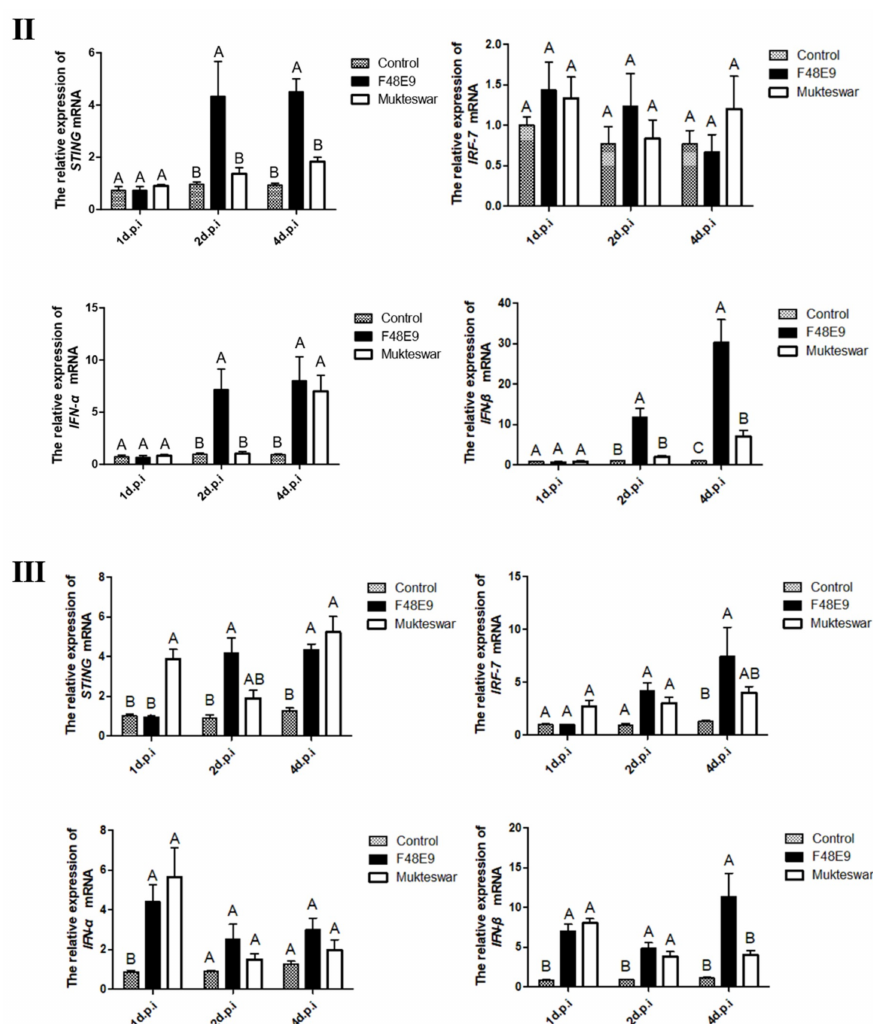
Figure 6. Expression of STING and its down-stream genes in the immune-related tissues of Newcastle disease virus (NDV)-infected chickens. (I) Specific pathogen-free (SPF) chicken were inoculated with NDV, the expression of STING and its down-stream genes in spleen were measured by real-time PCR. (II) SPF chicken were inoculated with NDV, the expression of STING and its down-stream genes in thymuses of were measured by real-time PCR. (III) SPF chicken were inoculated with NDV, the expression of STING and its down-stream genes in the bursa of fabricius were measured by real-time PCR. All data shown are the mean ± SD ( n = 3) and subjected into one-way analysis of variance (ANOVA) to identify differences between groups. Columns on the same dpi sharing completely different capital letters show significant difference ( p <